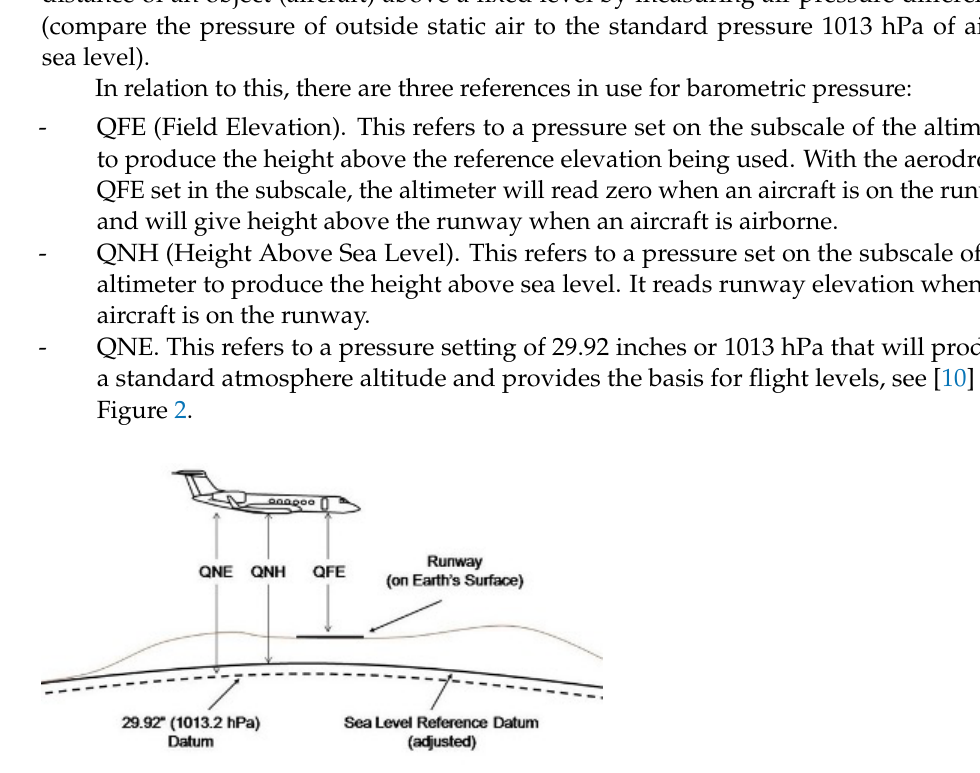
Figure 2. Flight